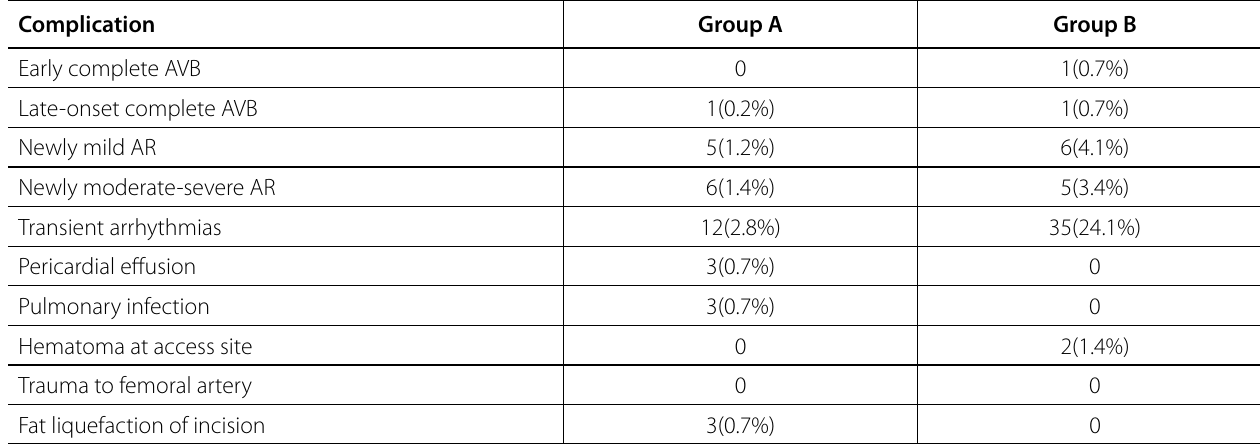
Table 3 . Complications in both